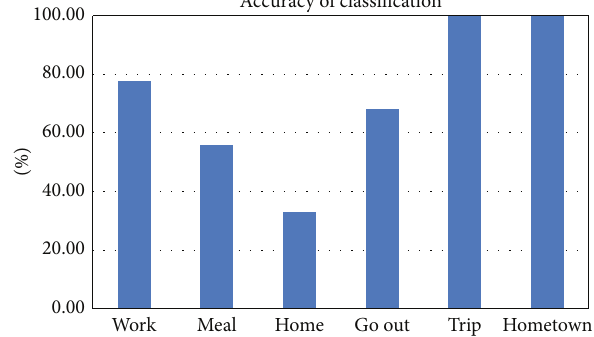
Figure 5: The accuracy of classification.